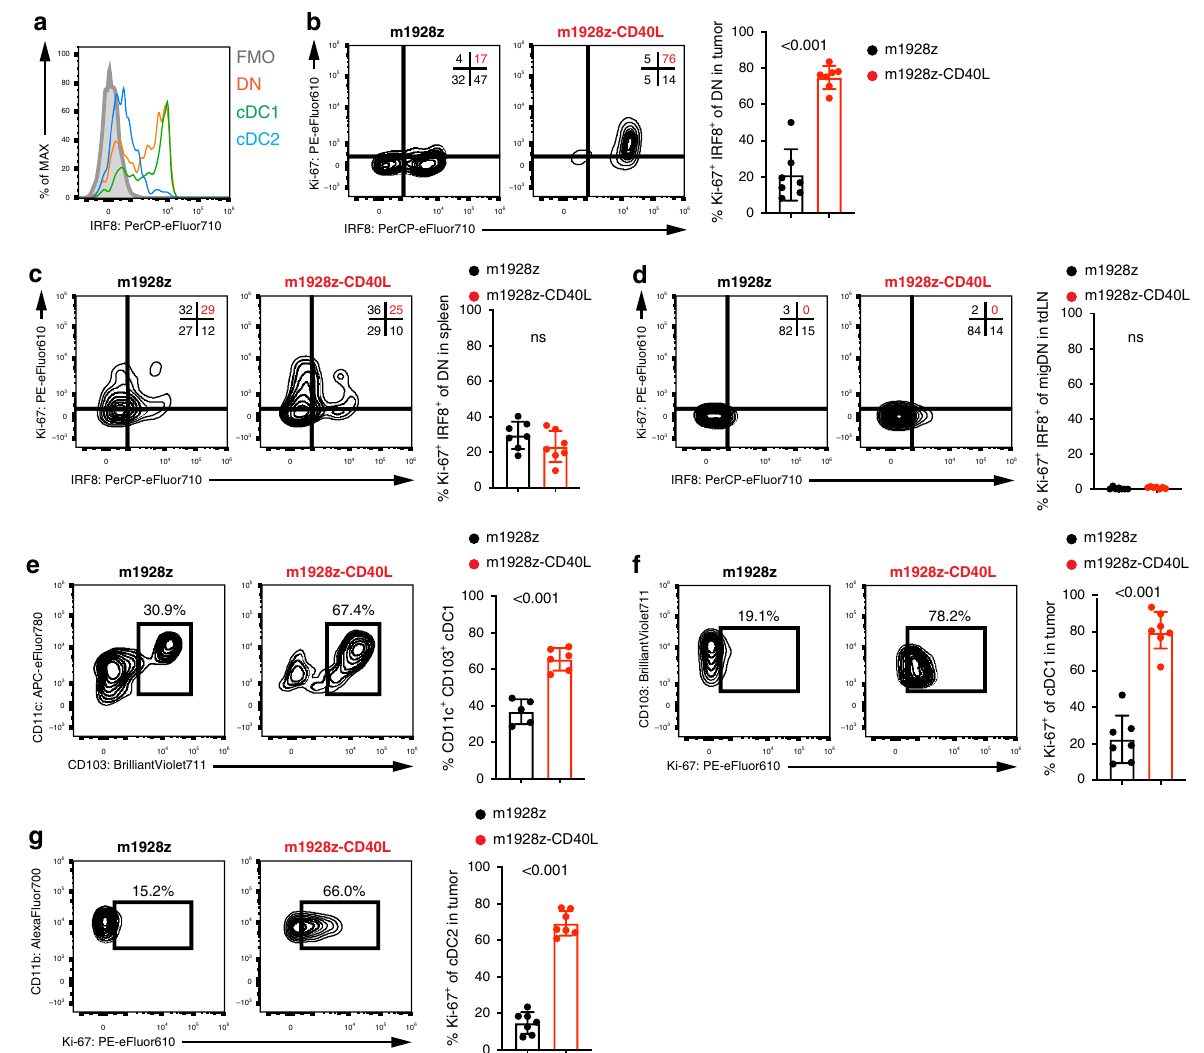
Fig. 3 m1928z-CD40L CAR T cells stimulate tumor-resident CD11b-CD103- DN cDCs to proliferate, upregulate IRF8, and differentiate to cDC1s. a